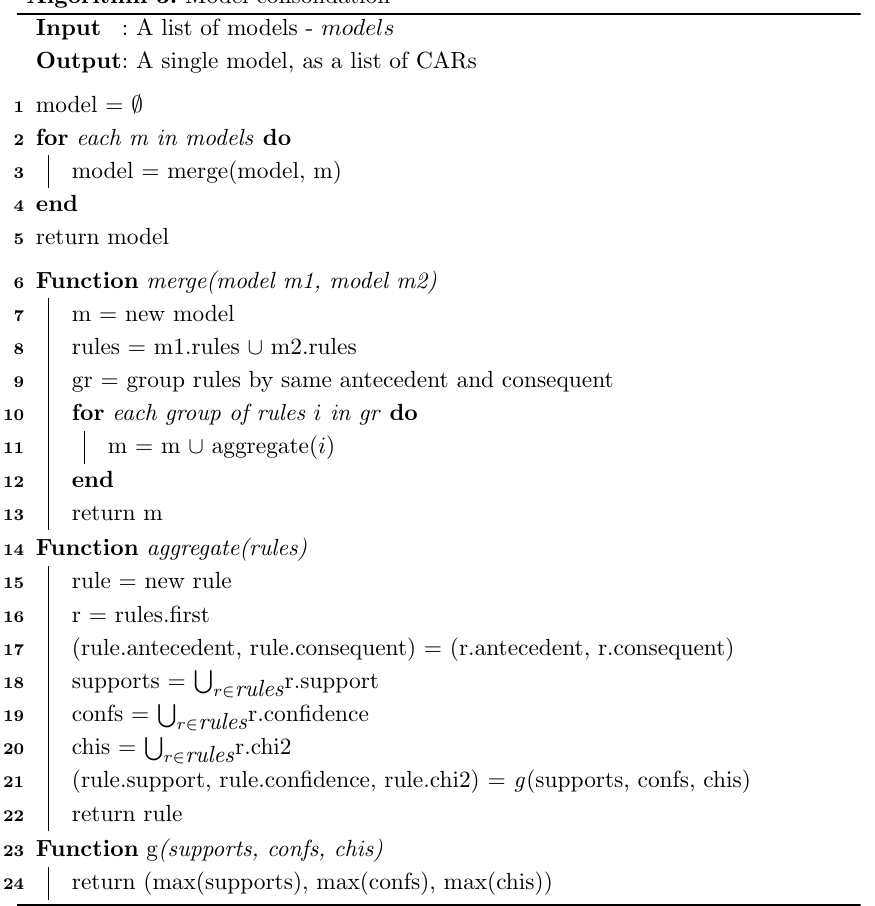
Algorithm 3: Model